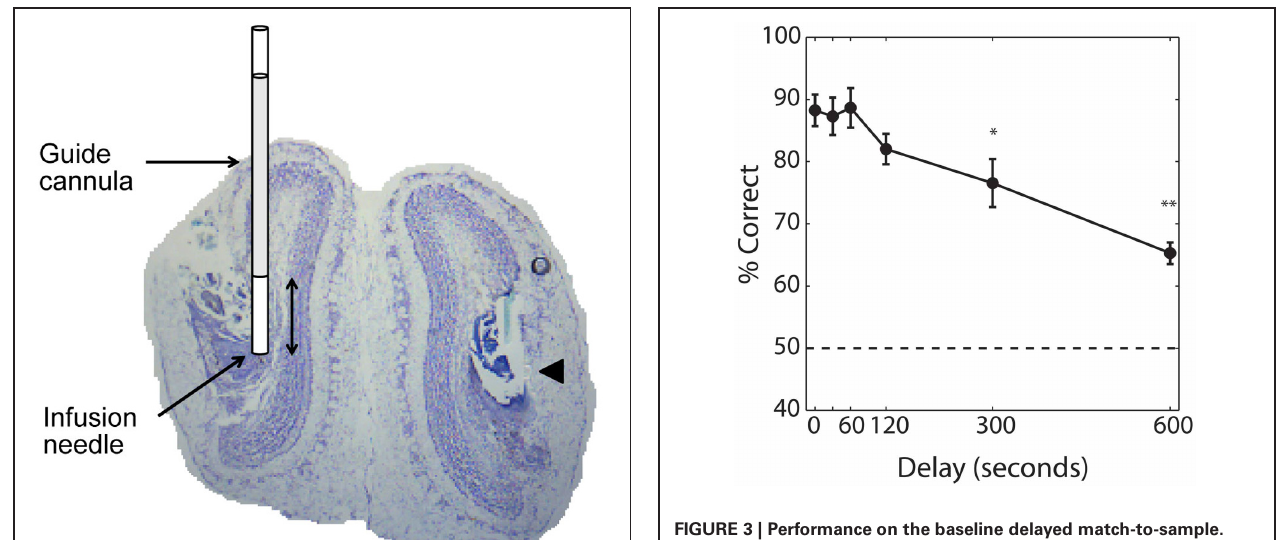
(Experiment 2) in which all odors— sample, match, and non- match— were identical. Average performance on this task was 48.39% ( ± 10.4%) and was not significantly different from chance ( P = 0 . 785), suggesting that rats are restricted to cues from the test odorants when solving the match-to-sample task.